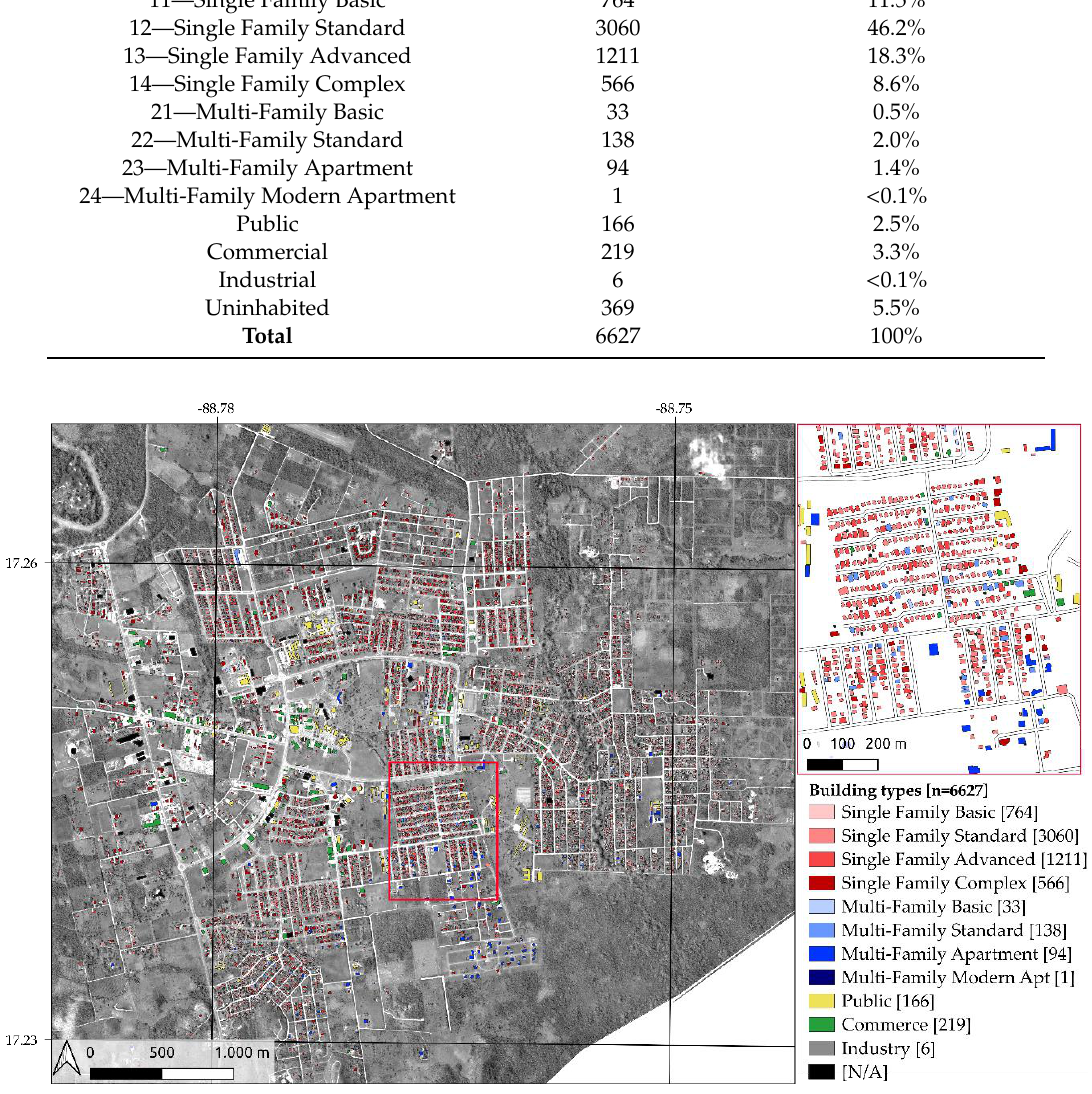
Figure 6. Map of detected buildings and classified building types in Belmopan (date: 2019/03/18). Total number of detected buildings: 6627. Manual assignment "Public", "Commerce", "Industry" on best knowledge. Background: PlanetLabs, 2018/03/18.; Stamen Design, Data by OpenStreetMap.